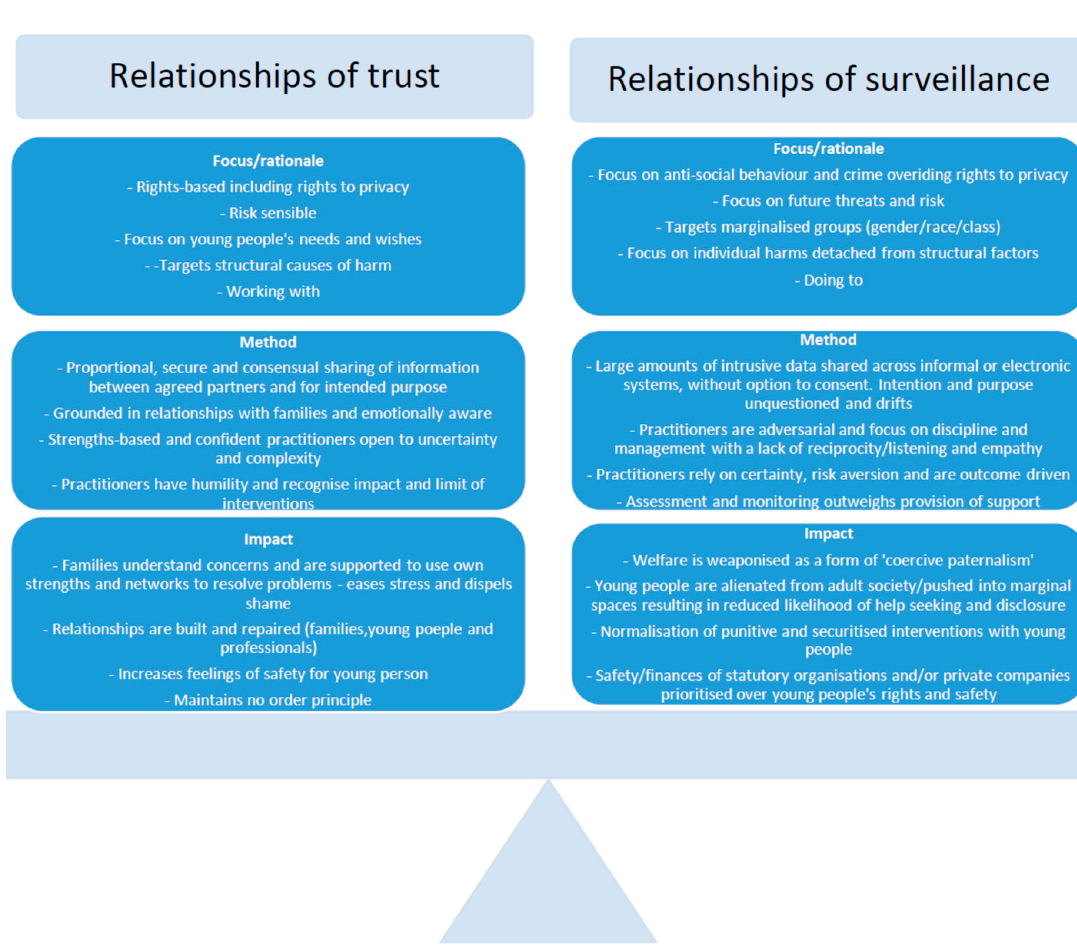
Figure 1. Relationships of trust or relationships of surveillance .